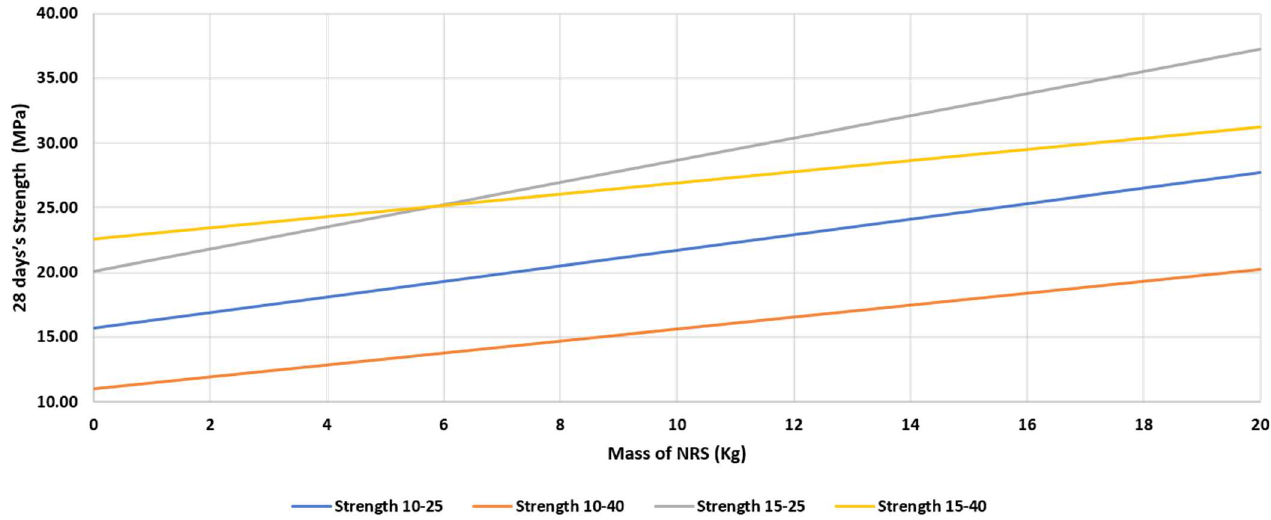
Figure 5. Evolution of the compressive strength of concrete according to the quantities of gravel and cement. Resistances 10–25 (in blue) and 10–40 (in grey), apply for the same quantity of cement of 10 kg using 25 kg and 40 kg of gravel, respectively. Resistances 15–25 (in red) and 15–40 (in yellow) mean the same quantity of cement of 15 kg with 25 kg and 40 kg of gravel, respectively.